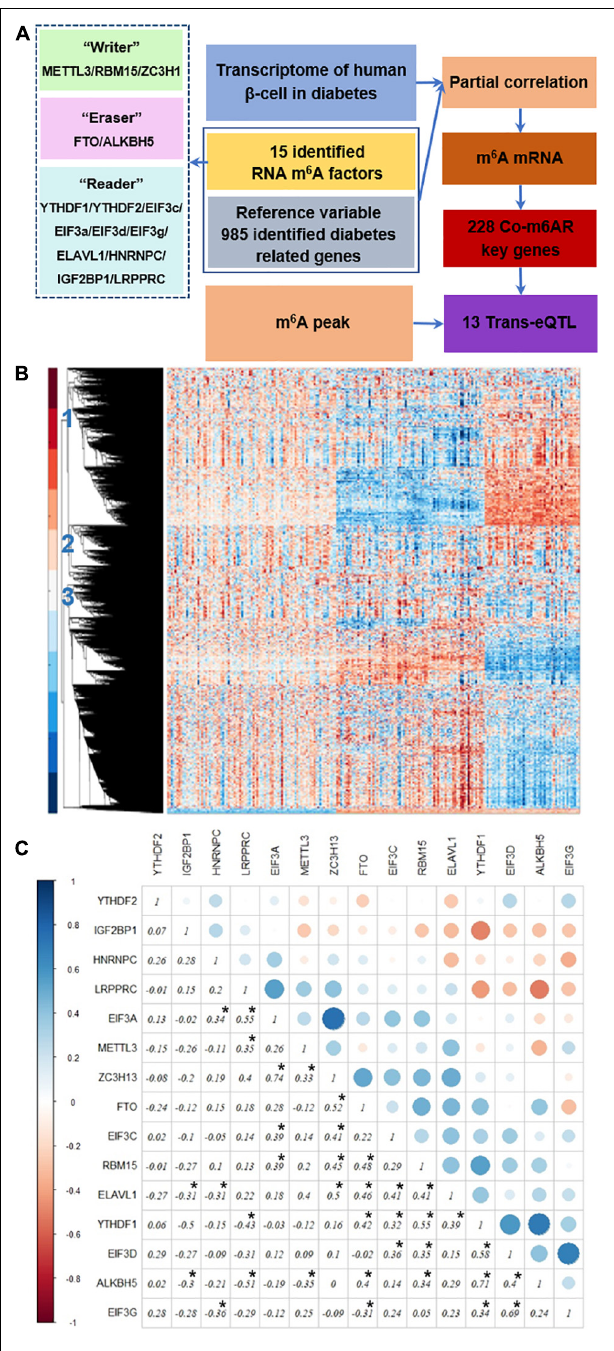
FIGURE 1 | Strategy to identify co-expressed genes with m 6 A regulators. (A) Strategy. The transcriptome data of islet β -cells from T2DM patients and controls was applied, then the genes co-expressed with RNA m 6 A regulators was then detected due to the partial correlation coefficient factors, co-m 6 AR genes were further identified based on the published RNA m 6 A modification profiles of β -cells, and finally screened out 13 eQTL-SNPs. (B) Transcriptome heatmap of detected genes with their differential expressions in control versus T2DM islet β -cells. Three types of differential expressed genes have been marked. (C) Co-expression among m 6 A regulators. The correlation coefficients of 15 RNA m 6 A methylation regulators have been shown and marked with black